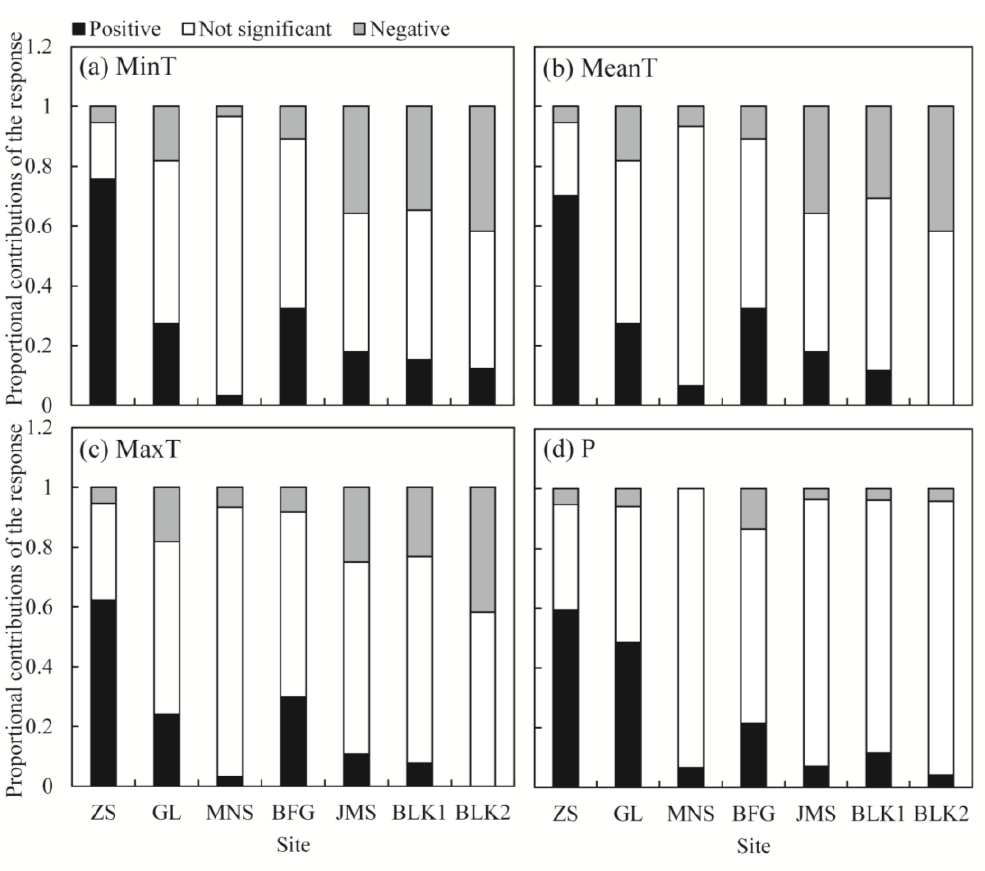
Figure 7. The proportional contributions of the significant positive, significant negative and not significant correlations between individual series and annual climate factors from 1960 to 2019. MinT: mean minimum temperature, MeanT: mean temperature, MaxT: mean maximum temperature and P: precipitation.